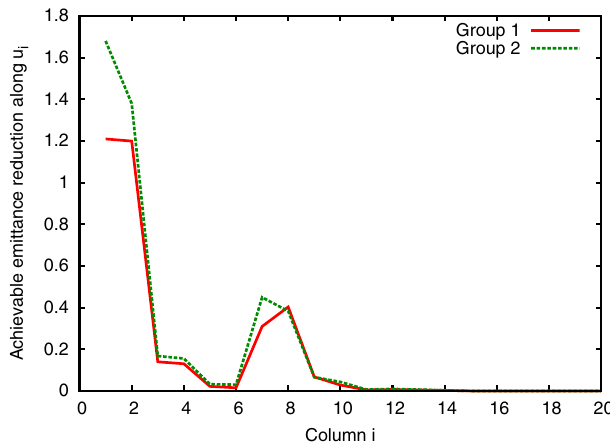
FIG. 13. Maximum achievable emittance reduction along the for two separate groups of ILC seeds. Note how columns of U K the strong directions 5 and 6 are nearly useless for emittance reduction. The reason is that the seeds that need to be corrected have very small components along these directions. They could otherwise have been used to correct emittance without using large quadrupole